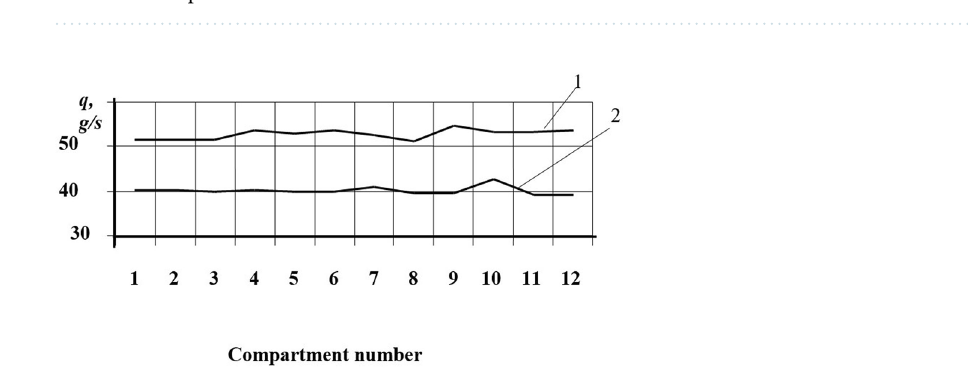
Figure 9. Distribution of seeds over compartments between the blades on the coinciding rotation move. Source: author’s development.